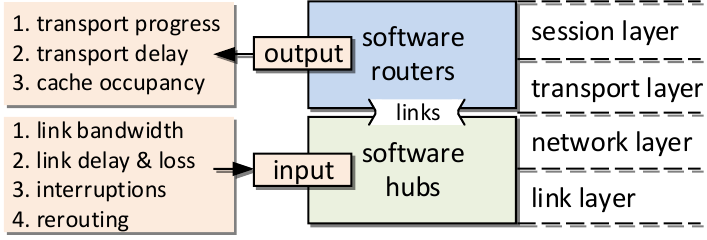
Figure 8. Designs of the IoV test platform